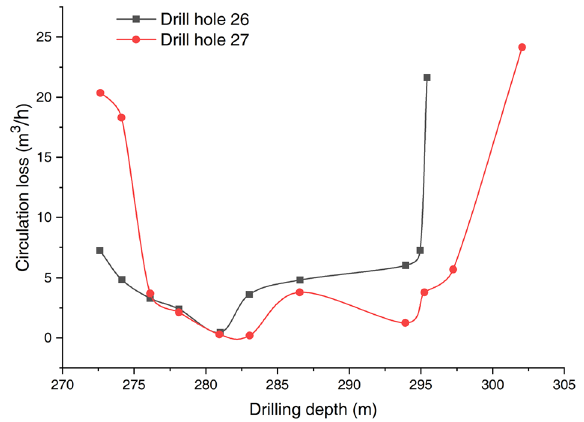
Fig. 8 Circulation loss of flush fluid as a function of drilling depth for boreholes Nos. 26 and 27